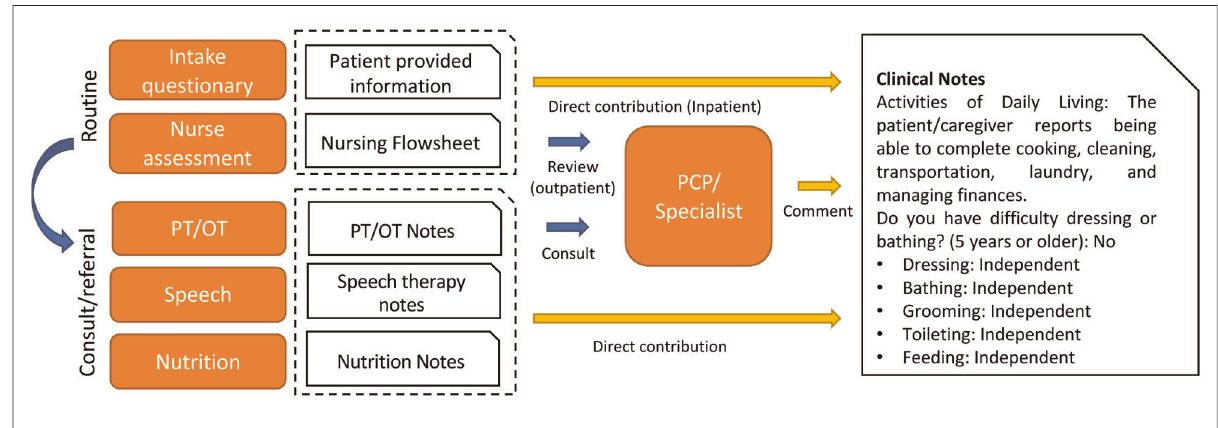
FIGURE 2 Overview of ADL documentation process at institution